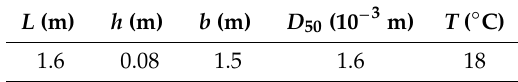
Table 1. Dimensions of the artificial dune and experimental conditions.